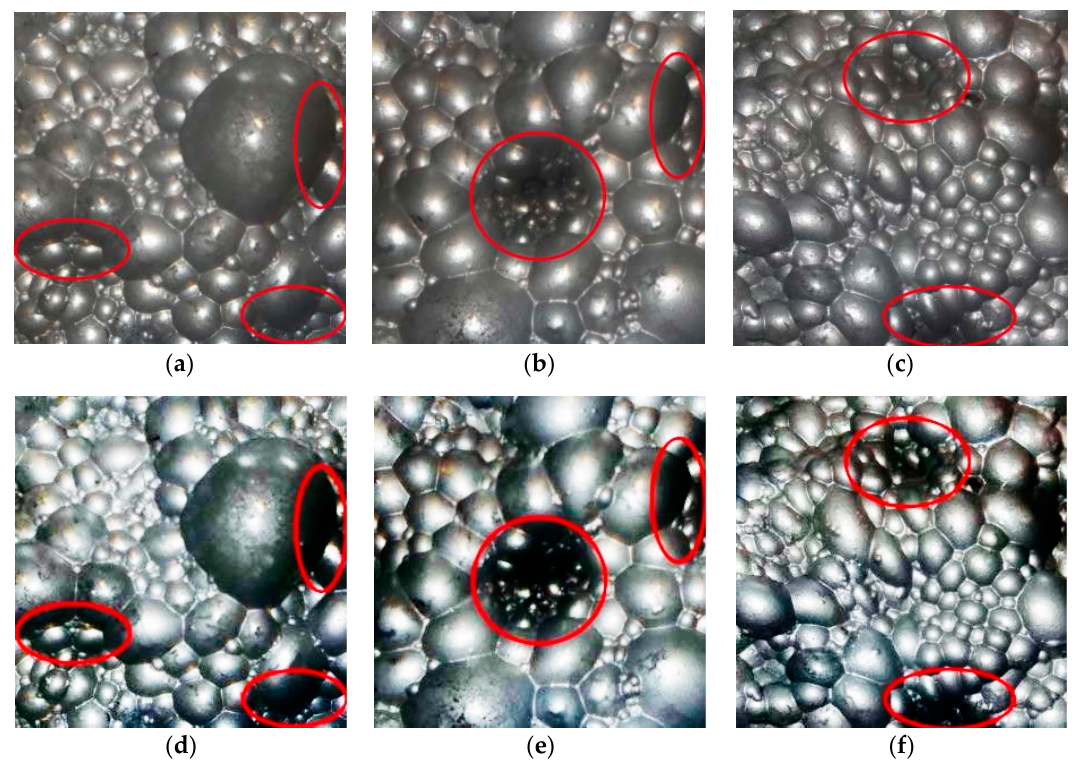
Figure 5. Different types of images acquired by using free-curved lens LED light (red-color-encircled parts are shaded parts), and their corresponding Histogram Equalization (HE) results. ( a ) First type; ( b ) Second type; ( c ) Third type; ( d ) HE on First type; ( e ) HE on Second type; ( f ) HE on Third type.